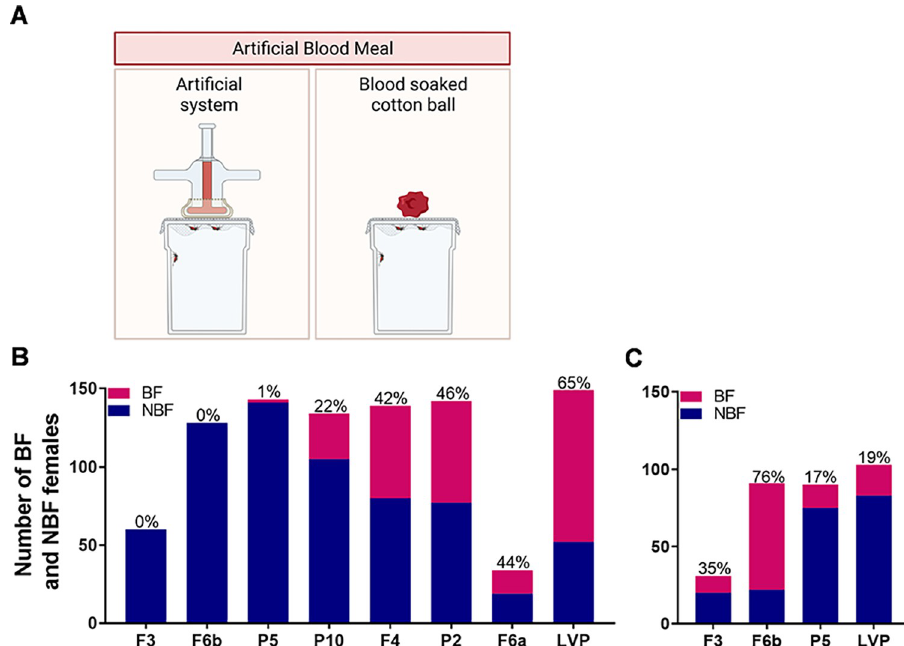
Fig 3. Transgenic females displaying higher levels of masculinization are not able to blood feed in the presence of a physical barrier. ( A ) Schematic representation of the two artificial blood meals offered, one with a physical barrier (artificial system) and one without the physical barrier (blood-soaked cotton ball) ( B ) Number of blood fed (BF) and non-blood fed (NBF) females from transgenic lines and Liverpool strain in the absence of Dox in the artificial blood meal system and ( C ) blood-soaked cotton ball. Percentages represent blood fed females. Illustrations were created using Biorender.com through a license to Texas A&M